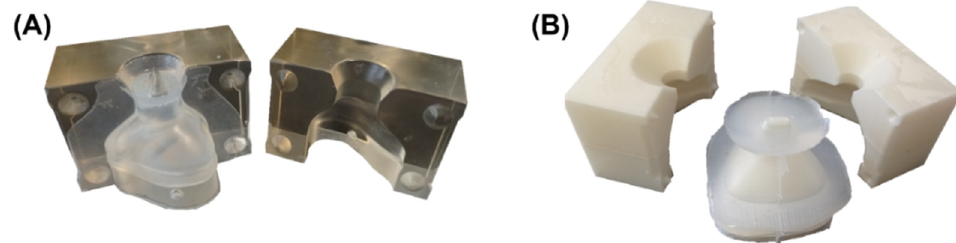
Figure 9. Casting mold for nasal and oronasal mask with cured silicone. ( A ) Nasal mask; ( B ) Oronasal mask.